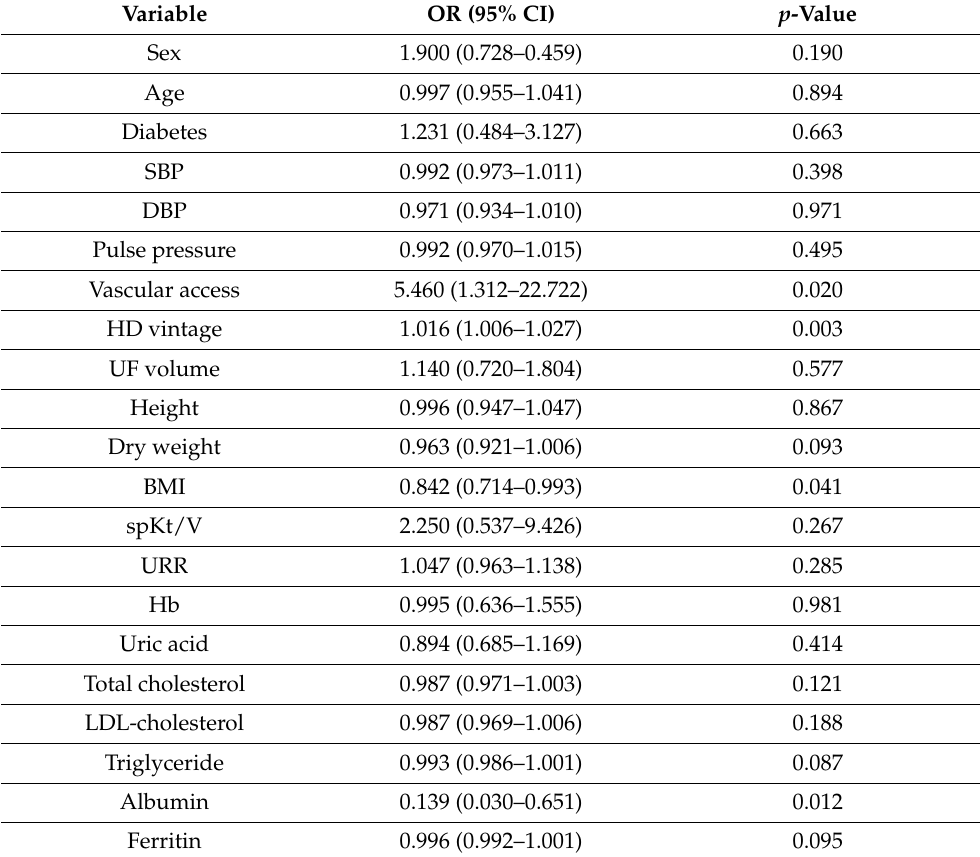
Table 2. Univariate logistic regression analysis to identify factors independently affecting vascular